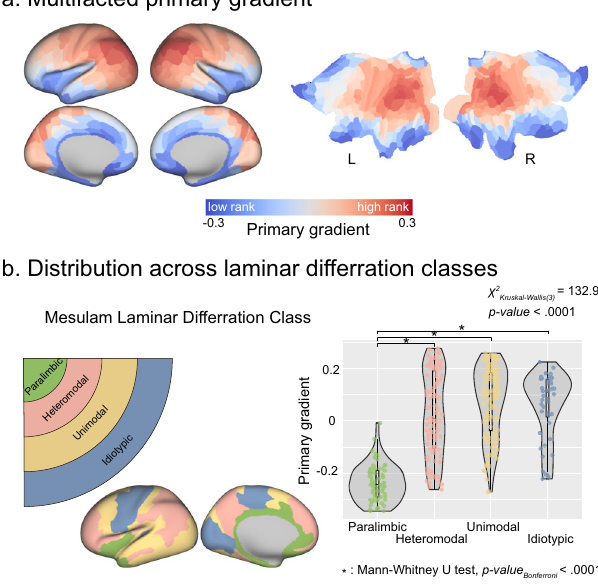
Fig. 2 Space distribution of the multifaceted functional gradient. a The fi rst component of embeddings, namely the primary gradient, was rendered on the in fl ated surface (left) and unfolded fl at surface (right). b According to the Mesulam laminar differentiation class atlas, the primary gradient was classi fi ed as a different class based on the corresponding spatial